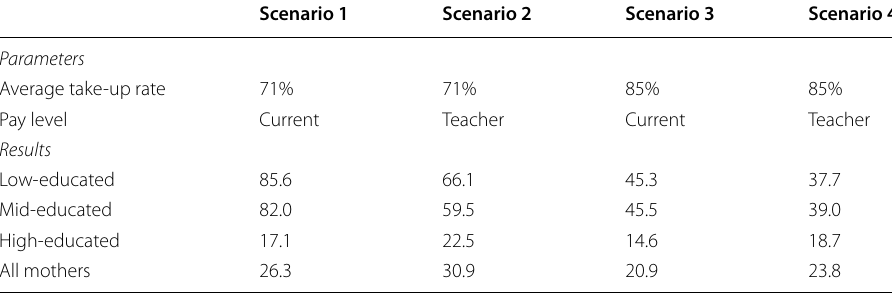
Source: own calculations using FRS data and UKMOD. Low‑educated mothers correspond to those having attained at most lower secondary education; mid‑educated mothers are those having attained upper secondary or post‑secondary education; high‑educated mothers are those with a